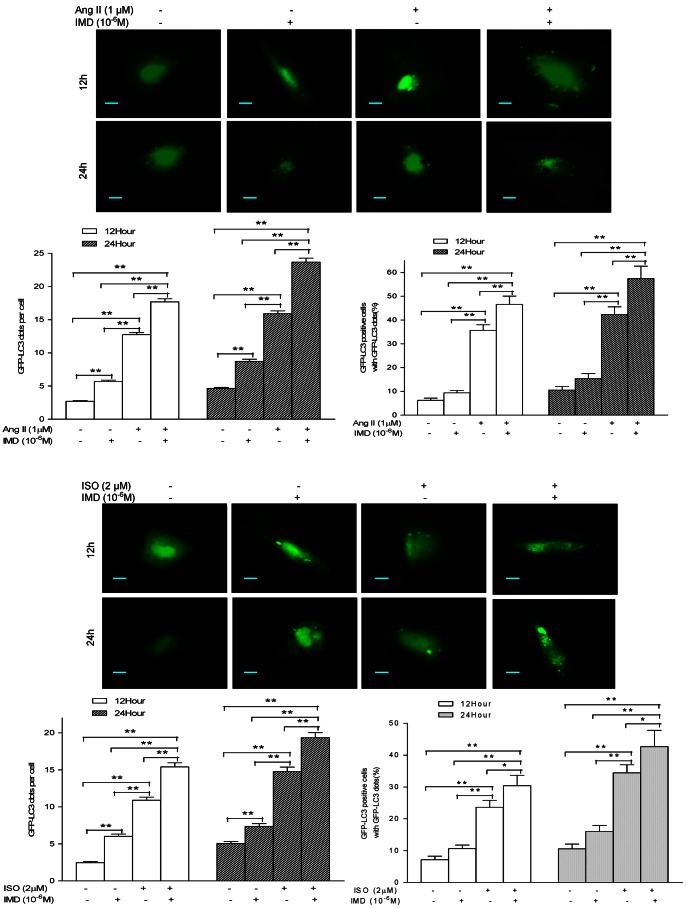
Representative fluorescence images showing the effect of exogenous IMD (10−6M) on the appearance of a punctate GFP-LC3 signal stirred by 1 µM Ang II or 2 µM ISO insult in H9c2 cells for 12 and 24 h transfected with a pEGFP-LC3 plasmid, respectively.Positive signals were defined as those cells that had five or more GFP-LC3 dots in the cytoplasm. The percentage of the cells with GFP-LC3 dots and the average number of GFP-LC3 dots per cell were analyzed from at least 100 random fields, and both of them were markedly increased by IMD supplementation at 12 h and 24 h, respectively. All data were statistically analyzed with One-Way ANOVA. *p<0.05; **P<0.01. IMD, intermedin; Ang II, angiotensin II; ISO, isoproterenol.